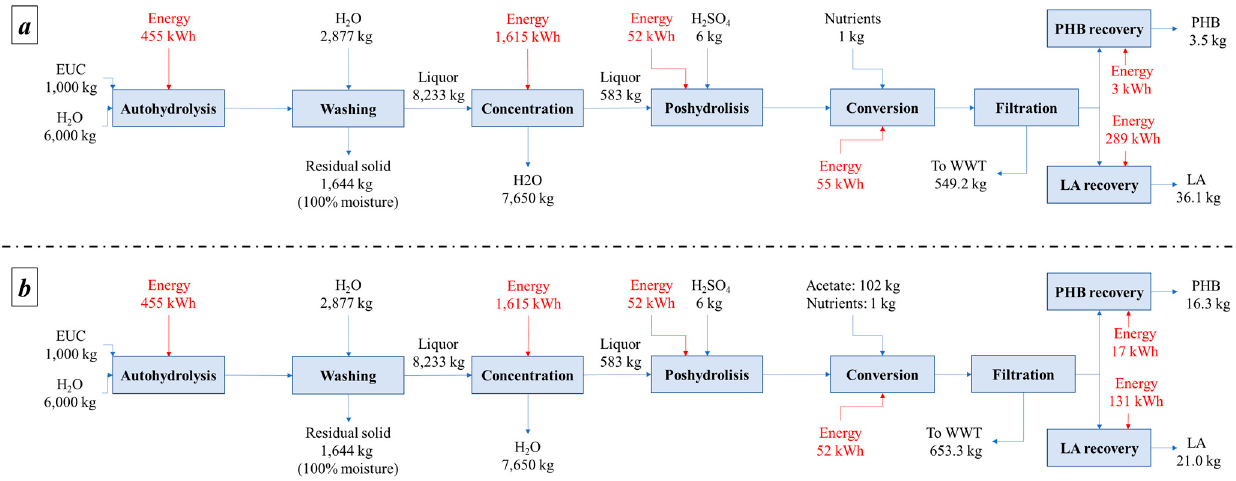
Figure 2. Mass and energy balances for the EUC valorization strategy ( a ) without acetate and ( b ) with acetate.